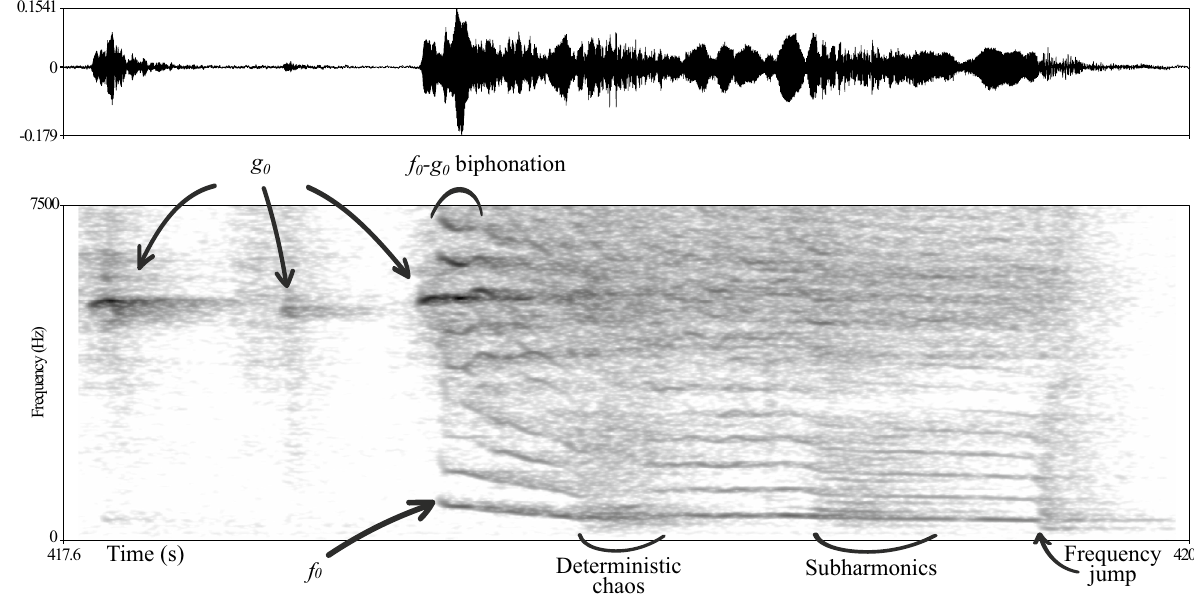
Figure 1. One example of a dog whine containing several types of non-linear phenomena. f 0 label identifies whines with the lower fundamental frequency, while g 0 the high secondary fundamental frequency (whistle whine or squeak in other nomenclatures). The co-occurrence of these two marked as biphonation which was not counted as NLP in the current analysis, while other type of NLP (deterministic chaos; subharmonics; frequency jump) were included. (The figure is the work of the first